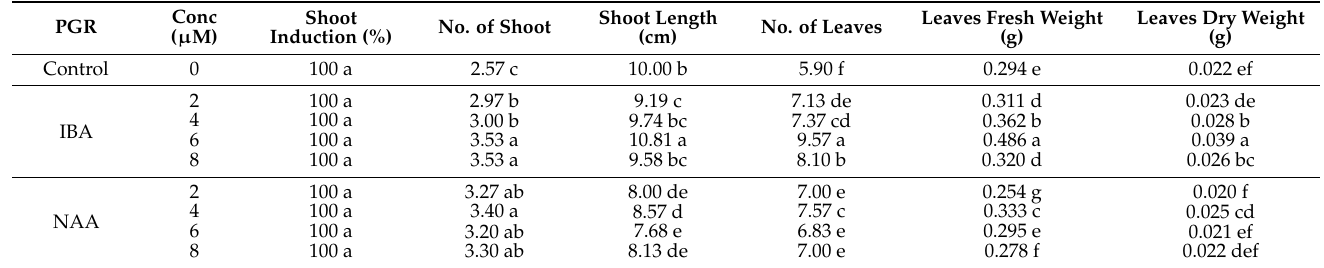
Table 3. Effect of 15 µ M of BAP with auxins in the MSB5 medium on enhancement of shoot multipli- cation of C. caesia